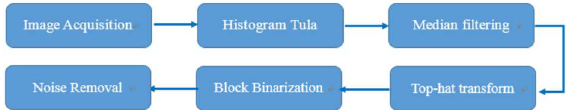
Figure 3: Procedure of the algorithm proposed by (Dapeng Qi, Yun Liu, Qingyi Gu, & Fengxia Zheng, October